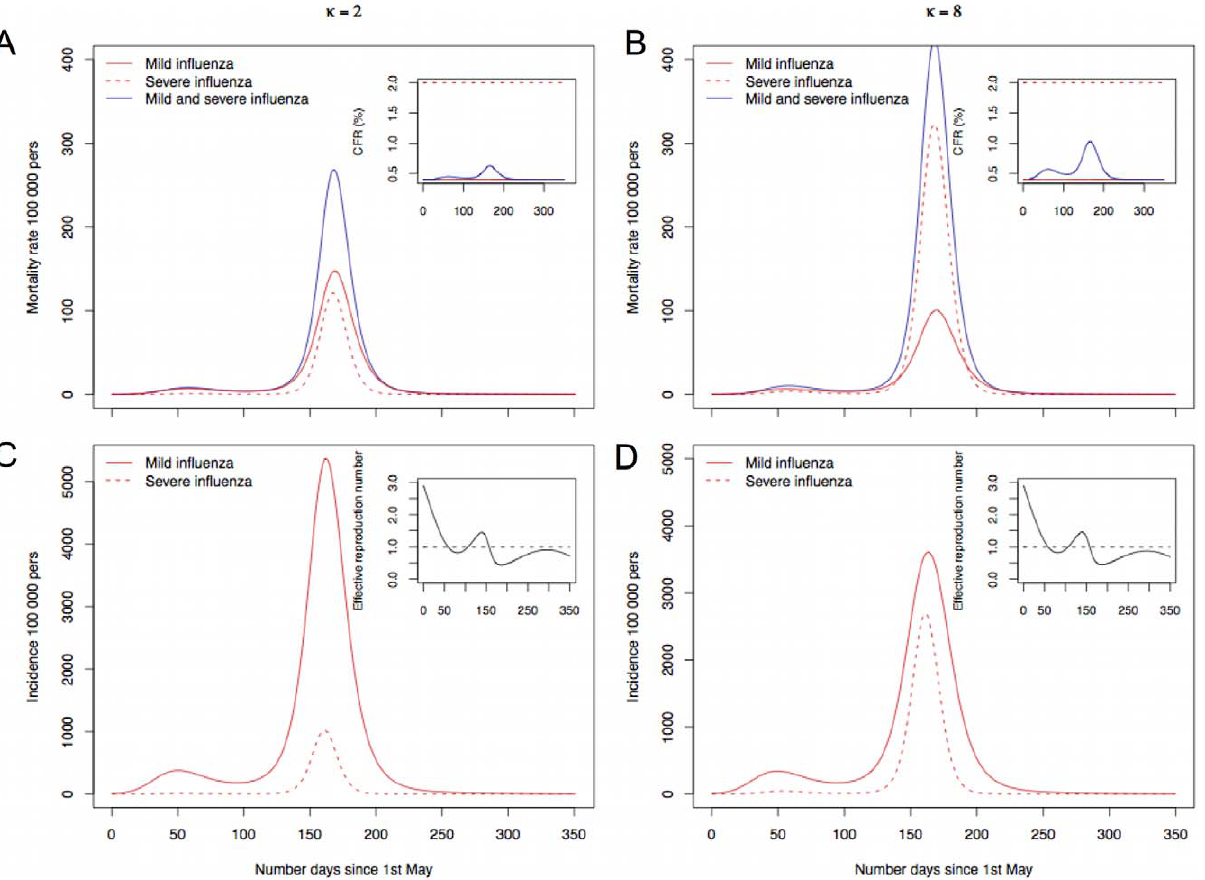
Figure 1. Incidence, mortality and case-fatality rate for influenza pandemic under different levels of multiple contacts between a susceptible person and infectious ones. A and B gives the mortality rate and the case-fatality rate for scenarios 1 ( k ~ 2 ) and 2 ( k ~ 8 ). C and D gives the corresponding incidence per 100 000 persons in the population and the effective reproduction rate.